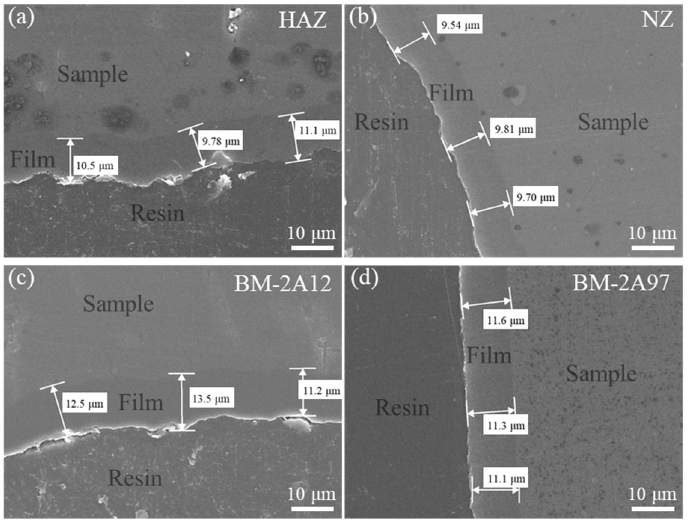
Figure 1. Section SEM images of the FSW joint after anodizing. ( a ) HAZ, ( b ) NZ, ( c ) BM-2A12 and ( d ) BM-2A97.